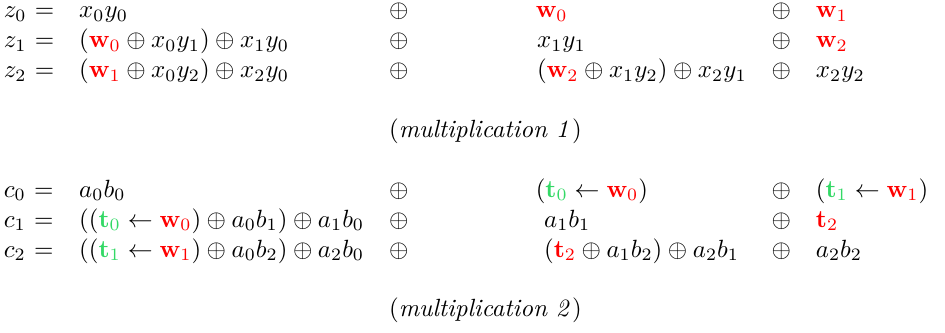
Figure 2: RRM scheme applied on two 2nd-order secure ISW multiplications, generating random elements w 0 and w 1 in multiplication 1 and recycling them in multiplication